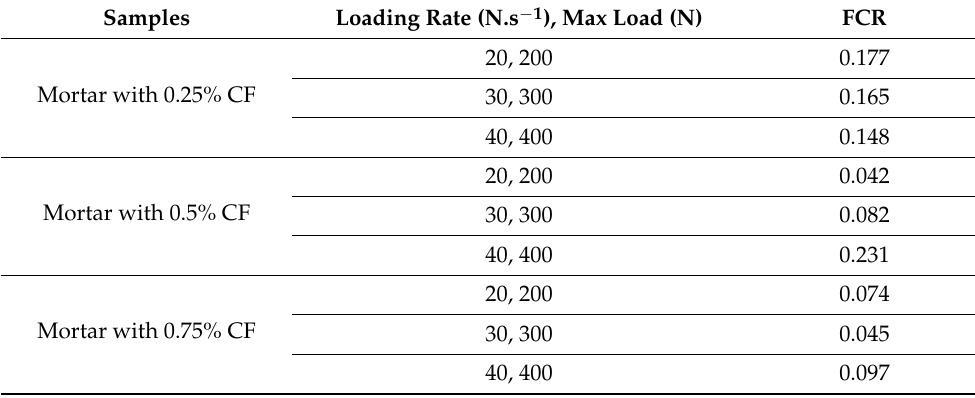
Table 4. Fractional resistance change of composites containing